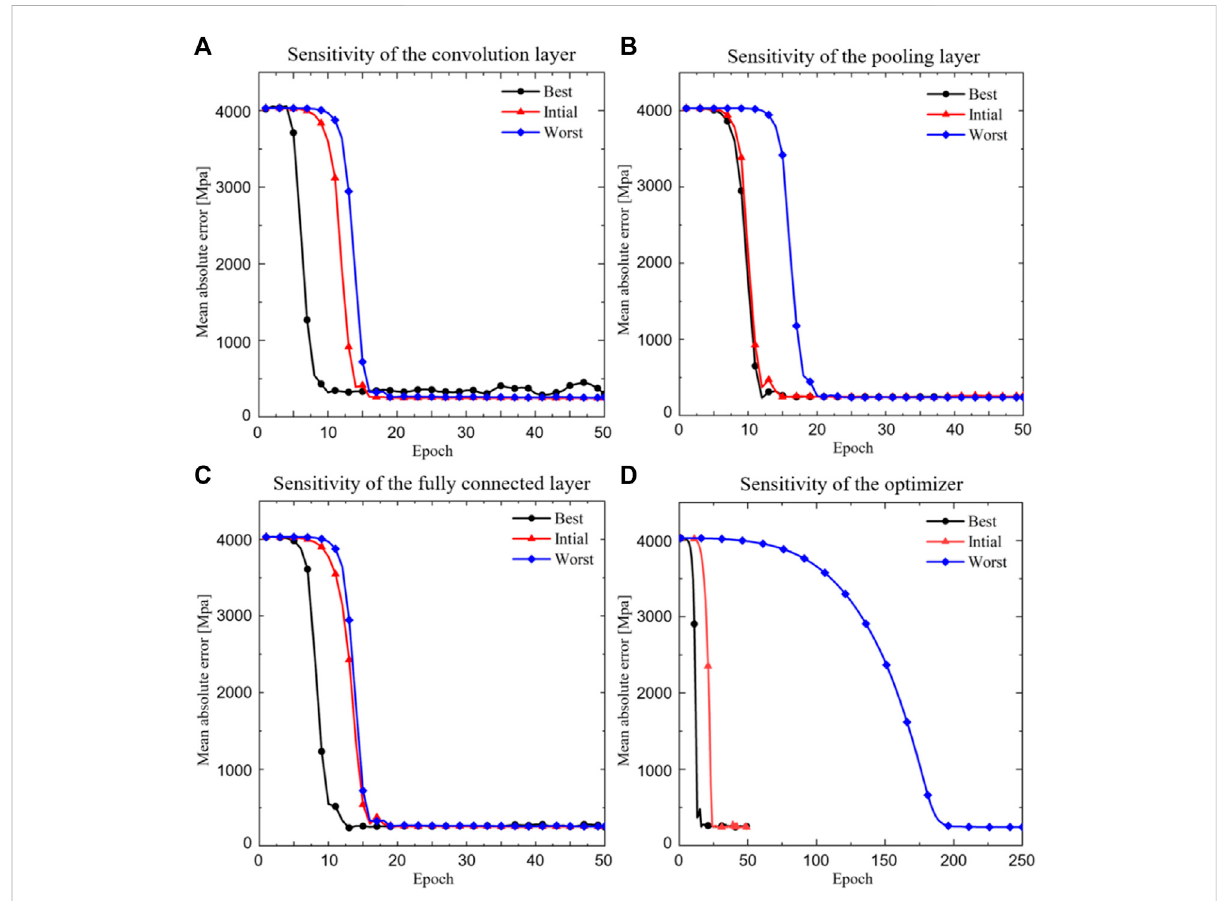
FIGURE 6 The relationship between the mean absolute error and the epoch. (A) Sensitivity of the convolution layer; (B) Sensitivity of the pooling layer; (C) Sensitivity of the fully connected layer and (D) Sensitivity of the optimizer ( ‘ Best ’ refers to the case with the fastest iterative convergence speed and the corresponding best parameters are listed in Table